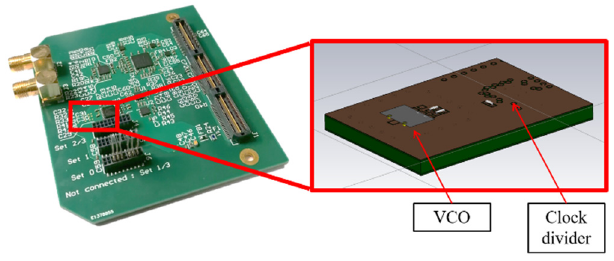
Figure 10. Analog to digital conversion PCB with 250 MHz clock generation area used as a 3D model. Table 3. Different BLS enclosure shielding compositions.